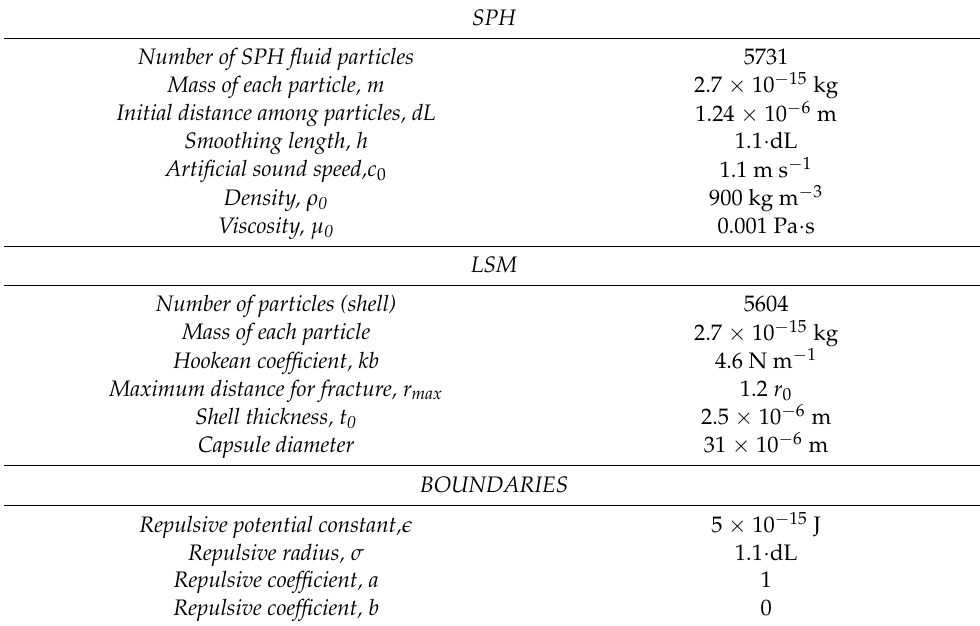
Table 1. Parameters needed for Discrete Multi-Physics